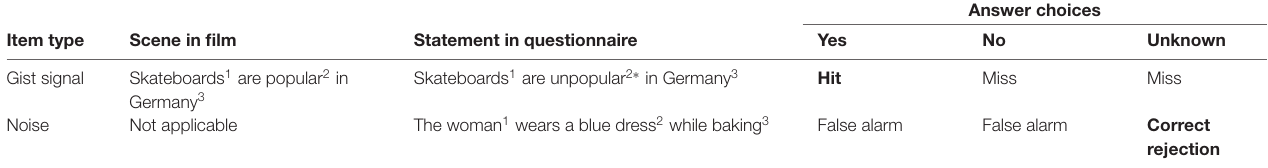
TABLE 6 | Scoring matrix for hits and false alarms used to assess sensitivity to gist